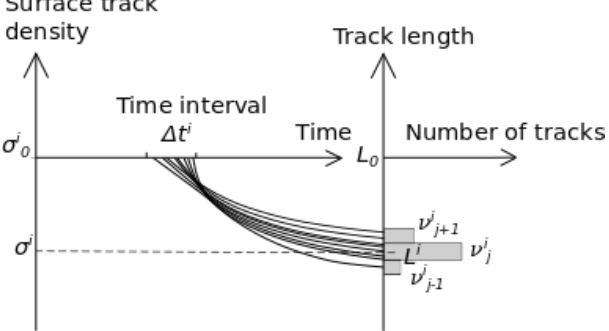
Figure 1. In the time interval (cid:49)t i , several tracks are spontaneously generated with the initial mean track length L 0 and surface density σ i . During anisotropic annealing over time, the initial length is re- 0 duced along the curved path and spread around the present mean length L i . Tracks from neighbouring time intervals are similarly spread and, consequently, mixed with tracks from the time interval (cid:49)t i